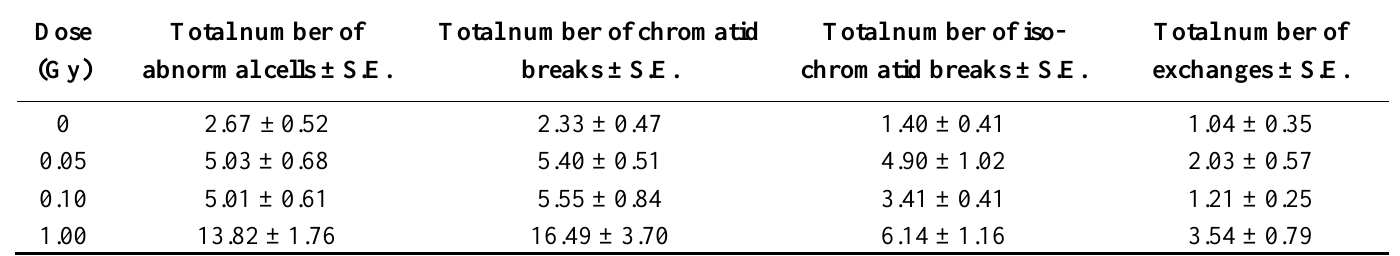
Table 3. Average square root transformation values (  X +  (X+1)) of mean aberrations in 100 cells scored ± standard error of the mean (S.E.) derived from the raw data of the frequencies of each type of aberration, including abnormal cells as shown in Table 1 (1 h post-irradiation).